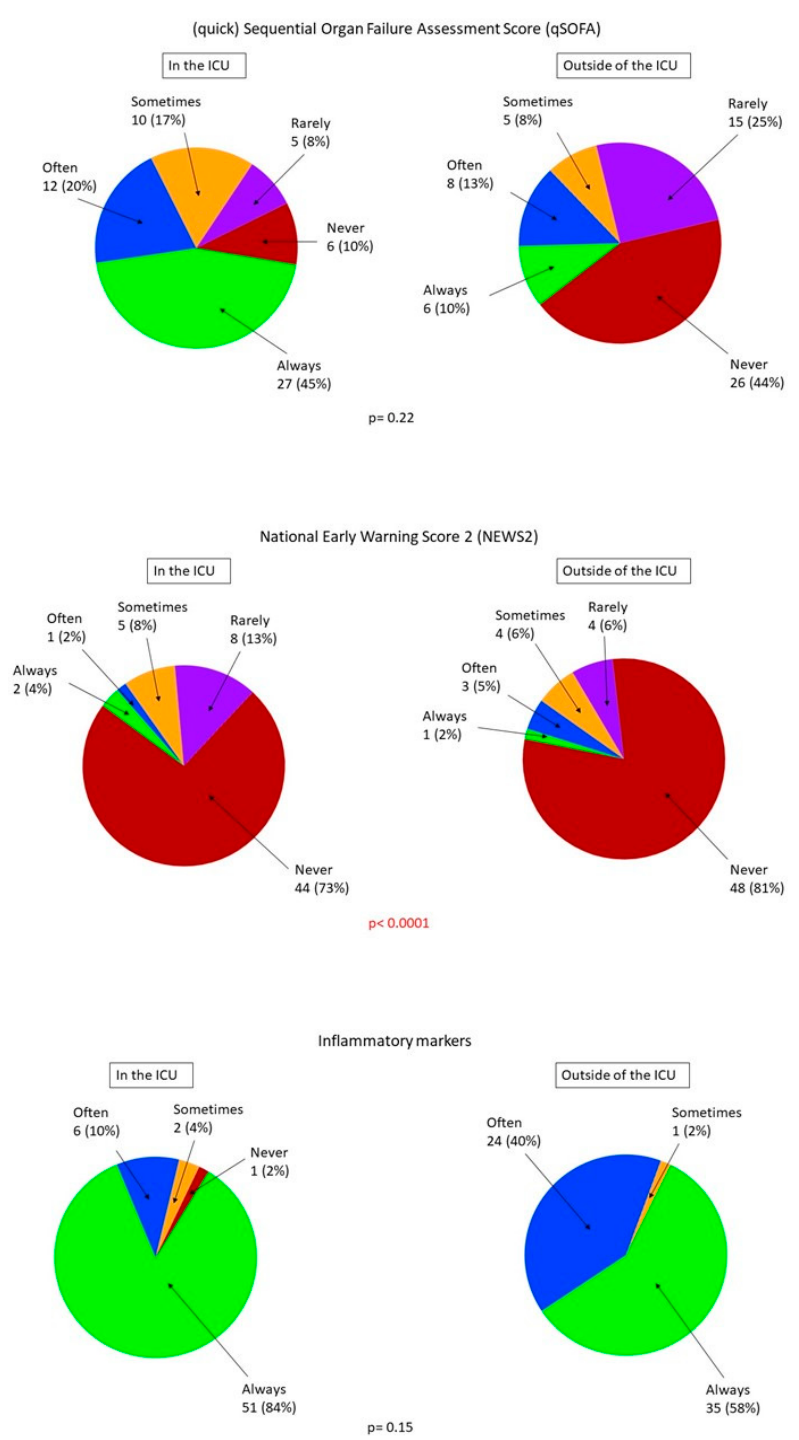
Figure 2. Methods of sepsis screening used in the ICU and outside the ICU. The Quick Sequential Organ Failure Assessment Score (qSOFA) includes one point for each of the following: respiratory rate ≥ 22, SBP ≤ 100 mm Hg, and altered mental status. For screening purposes, a cut-off of two points is used [14]. National Early Warning Score 2 (NEWS2) assigns points to measurements of respiratory rate, SpO 2 , air or oxygen ventilation, systolic blood pressure, pulse, state of consciousness, and body temperature, with increasing severity the higher the calculated sum [14]. Inflammatory parameters include any of the following: C-reactive protein (CRP), procalcitonin (PCT), interleukin 6 (Il-6), tumor necrosis factor (TNF), white blood cell count (WBC), and the neutrophil–lymphocyte ratio